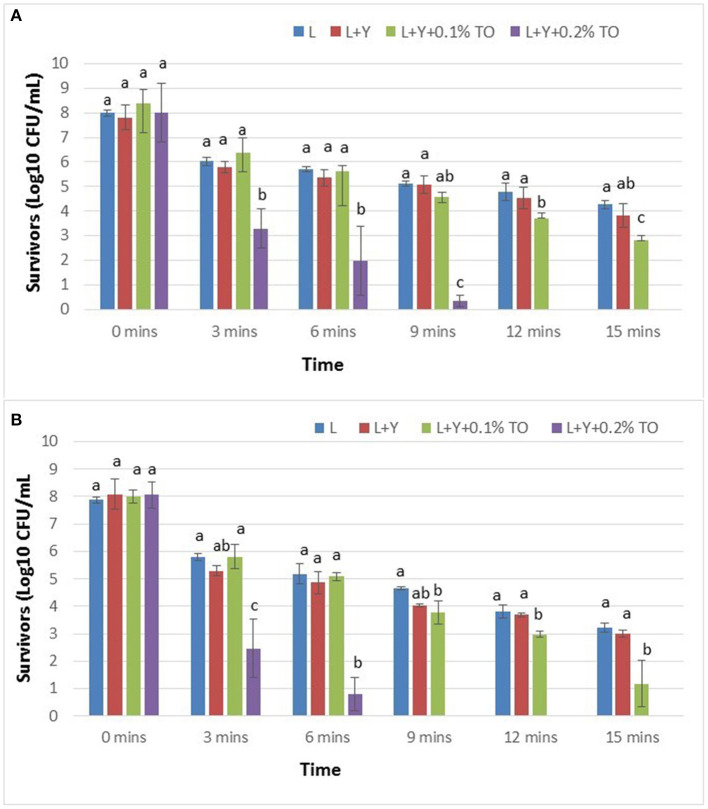
Survivors of Salmonella enterica planktonic cells in lemon juice marinades based on bacterial colony counts on TAL medium (A) and on XLT4 agar (B).